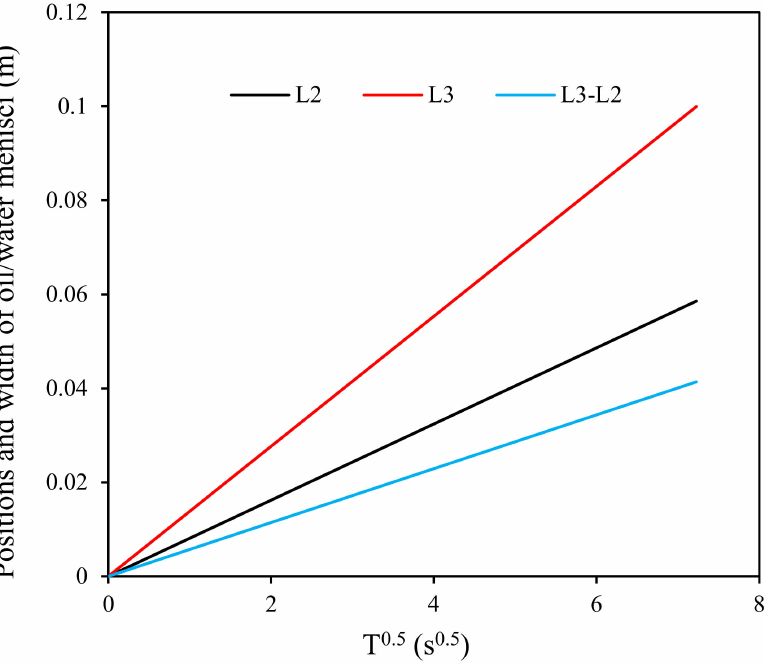
Figure 3. Variation of the imbibition front of two smaller